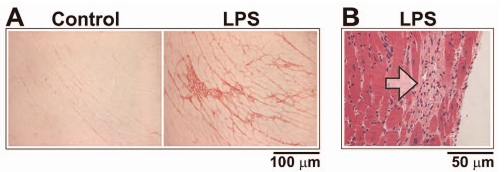
Figure 6. Cardiac fibrosis induced by weekly subclinical LPS. Panel A. Picrosirius staining was greater in a mouse injected with LPS 10 mg/kg/week for 12 weeks, compared with a control mouse injected weekly with saline. Panel B. H & E staining showed evidence of myofiber loss with replacement by fibrosis (arrow) after 15 weeks of LPS 20 mg/ kg/week.